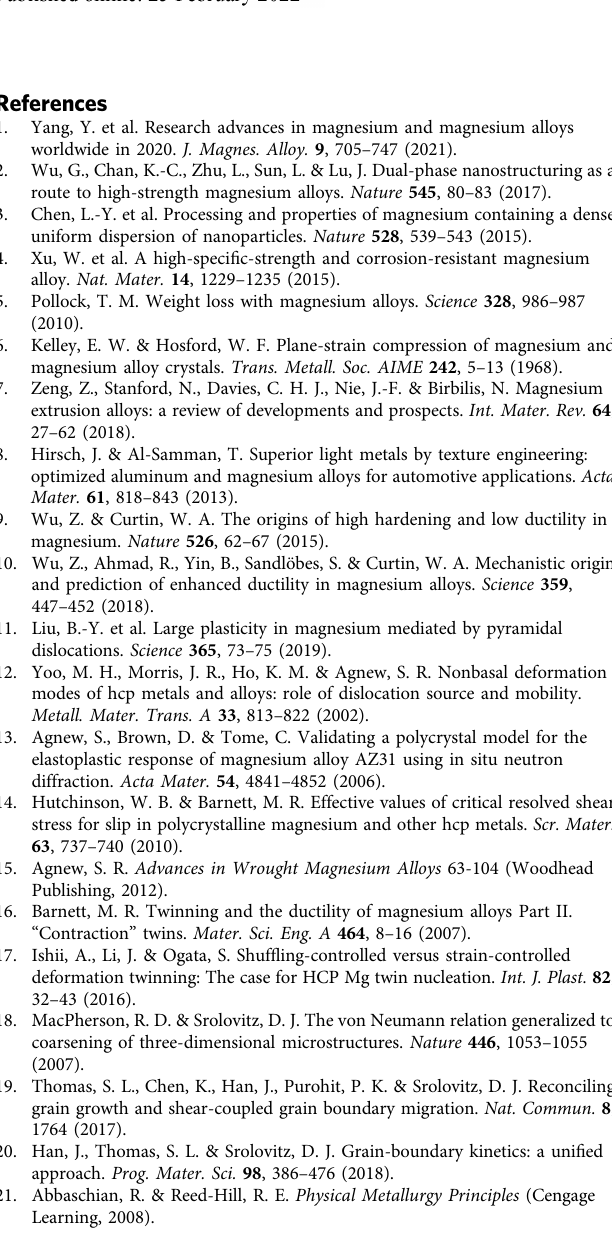
Supplementary Table 4. This method of strain-component analysis was developed by a previous work 42 . Data